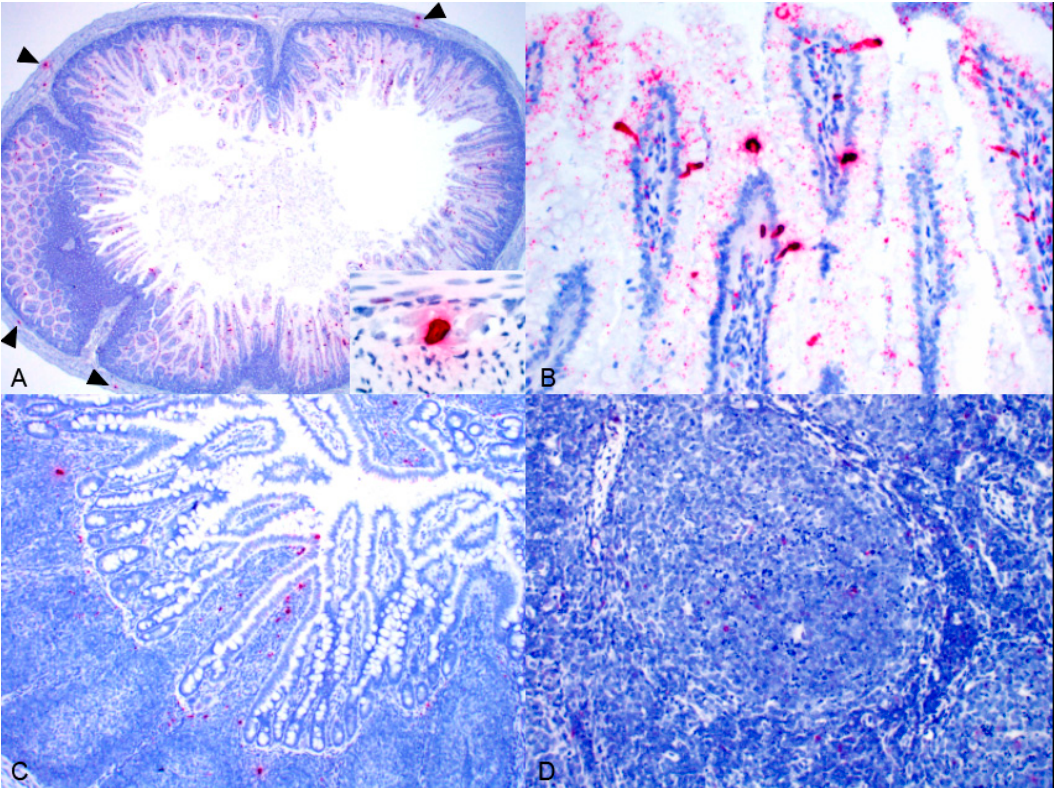
Figure 2. PoAstV3 detected by ISH (red labeling) in the enterocytes and myenteric plexus neurons (arrowhead and inset) of the jejunum of Pig 4 ( A ), enterocytes and lamina propria of the jejunum of Pig 13 ( B ), enterocytes, lamina propria and Peyer’s patches of the ileum of Pig 10 ( C ), and germinal center and mantel zone of the mesenteric lymph node of Pig 4 ( D ).